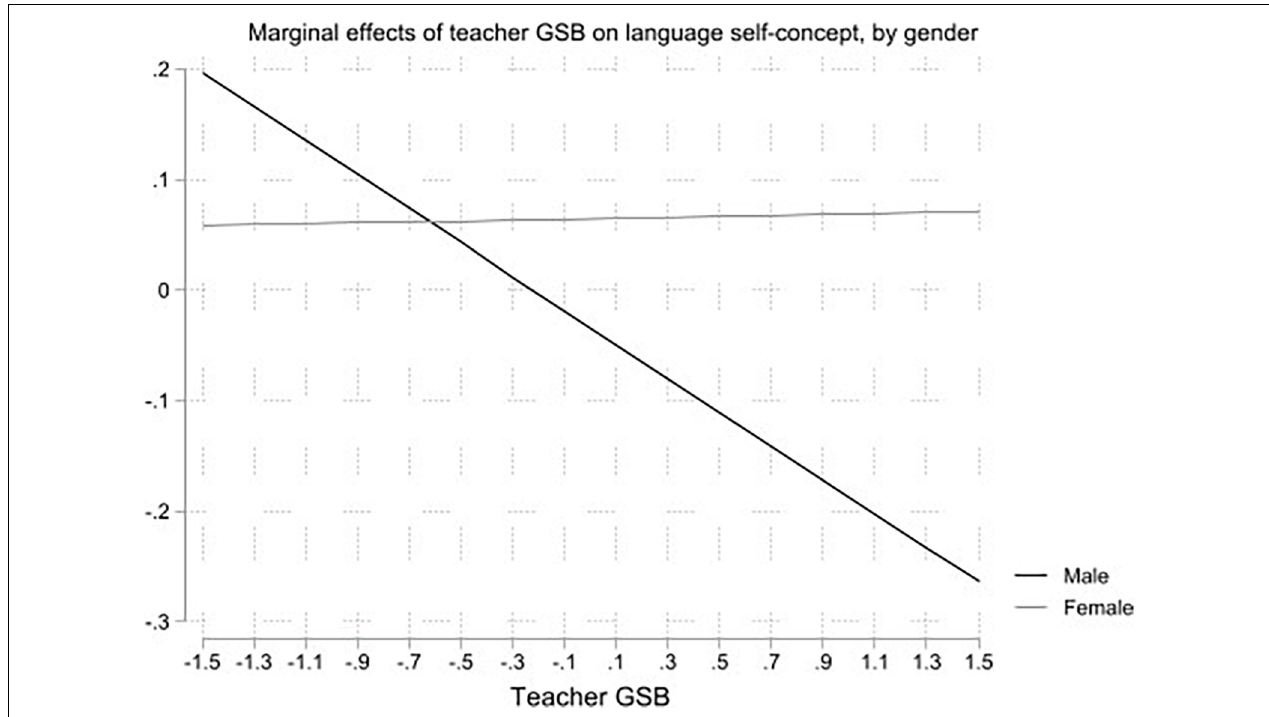
FIGURE 1 | Teacher gender-stereotypical belief (GSB) and predicted language self-concept by gender. Marginal effects of teacher GSB on language self-concept by gender. Based on estimates from Model 6 in Table 2